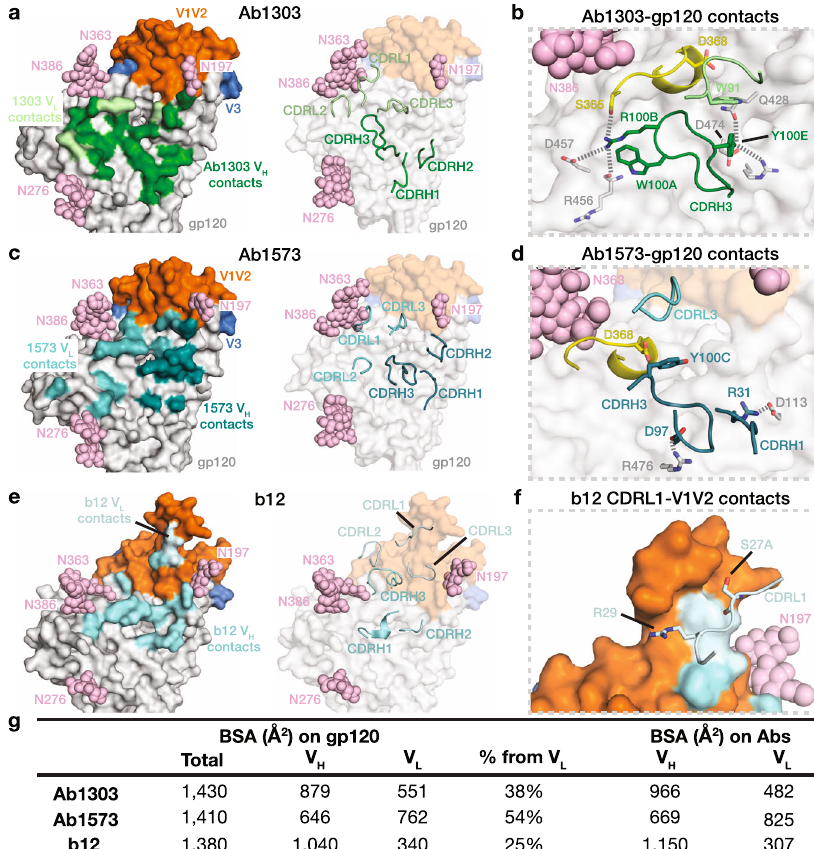
Fig. 3 Ab1303 and Ab1573 recognize the CD4bs of BG505 Env trimer. a Left: epitope of Ab1303 on gp120 surface with contacts made by antibody heavy and light chains colored in dark and light green, respectively. Right: CDR loops of Ab1303 mapped onto the gp120 surface. b Highlighted interactions between gp120 residues (gray sticks) and the Ab1303 CDRH3 (green sticks). The gp120 CD4 binding loop is shown in yellow with D368 gp120 residue highlighted in stick representation. c Left: epitope of Ab1573 on gp120 surface with contacts made by antibody heavy and light chains colored in dark and light teal, respectively. Right: CDR loops of Ab1573 mapped onto the gp120 surface. d Highlighted interactions between gp120 residues (gray sticks) and the Ab1573 CDRH1 and CDRH3 (teal sticks). CD4 binding loop of gp120 is shown in yellow with D368 residue shown in stick. e Left: epitope of b12 on gp120 surface with contacts made by antibody heavy and light chains colored in dark and light cyan, respectively. Right: CDR loops of b12 mapped onto the gp120 surface. f Highlighted interactions between gp120 V1V2 and the b12 V L . g Comparison of the buried surface areas (BSAs) between the antibodies and